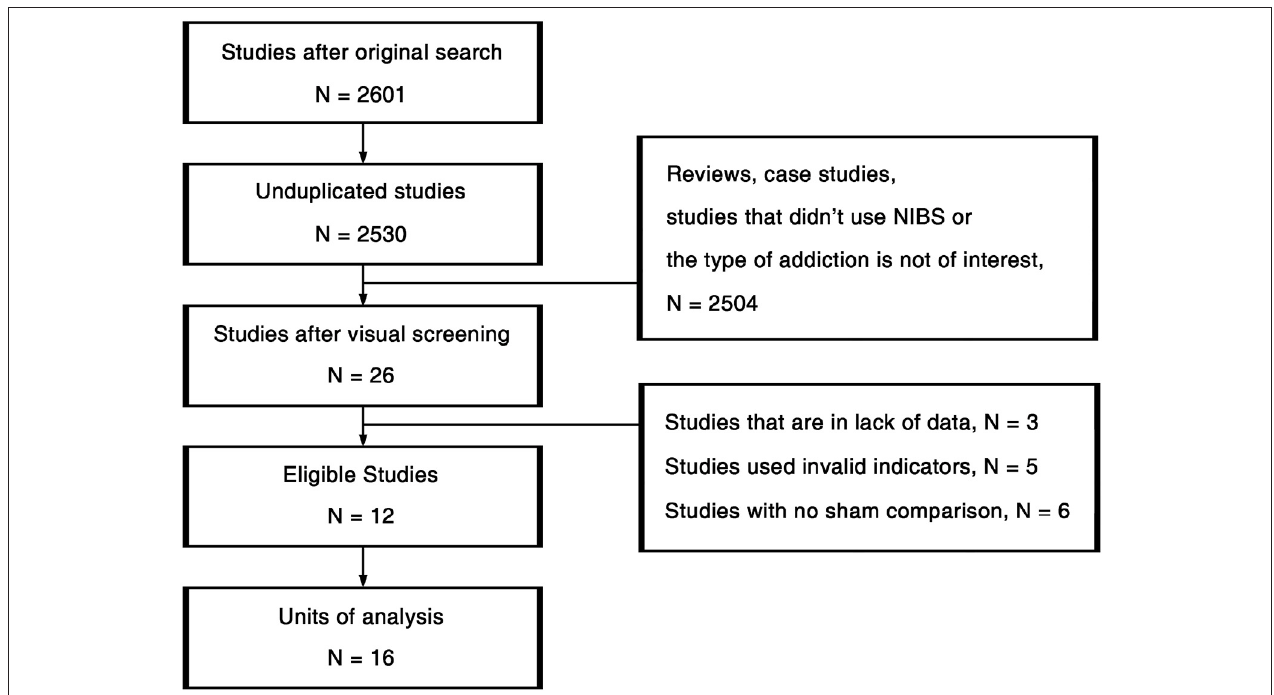
FIGURE 2 | Flow diagram of the study selection